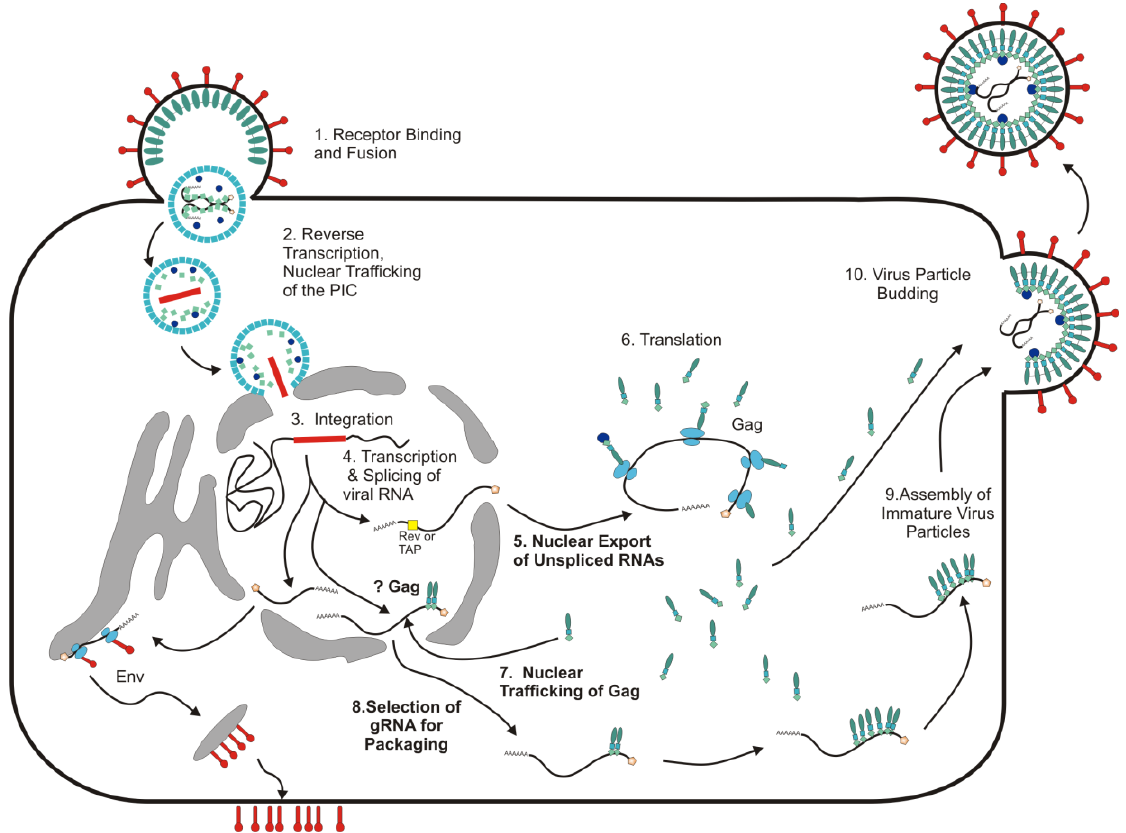
Figure 1. Model of retrovirus replication. Retroviral infection is initiated with binding of the viral Env protein to a cell surface receptor and fusion of the viral envelope with the cellular membrane (step 1). The viral RNA genome is reverse transcribed from RNA to DNA (step 2) to form the provirus, which is stably integrated into the genome of the host cell (step 3). Viral RNA is transcribed by the host polymerase II, and a portion of the RNA is spliced to direct the translation of the Env glycoprotein and other viral proteins (step 4). A portion of the viral RNA remains unspliced and is exported from the nucleus by the host factor TAP/NXF1 (e.g., simple retroviruses MPMV and RSV) or virally encoded Rev-like proteins (e.g., complex retroviruses like HIV-1 and HTLV-I) (step 5) to serve as a template for Gag and Gag-Pol translation (step 6). The Gag proteins of some retroviruses traffic through the nucleus during assembly (step 7). It has been postulated that the nuclear population of Gag (denoted by “?”) might select genomic RNA (gRNA) and transport it into the cytoplasm for packaging. Alternatively, selection of genomic RNA may occur in the cytoplasm (step 8). In either case, the Gag-gRNA complex is transported to the plasma membrane (step 9) where additional Gag molecules bind the viral RNP to complete assembly of the immature virus particle, which buds from the plasma membrane (step 10). The steps in replication that are covered in this review are indicated in bold. Figure modified from [22] and used with the author’s